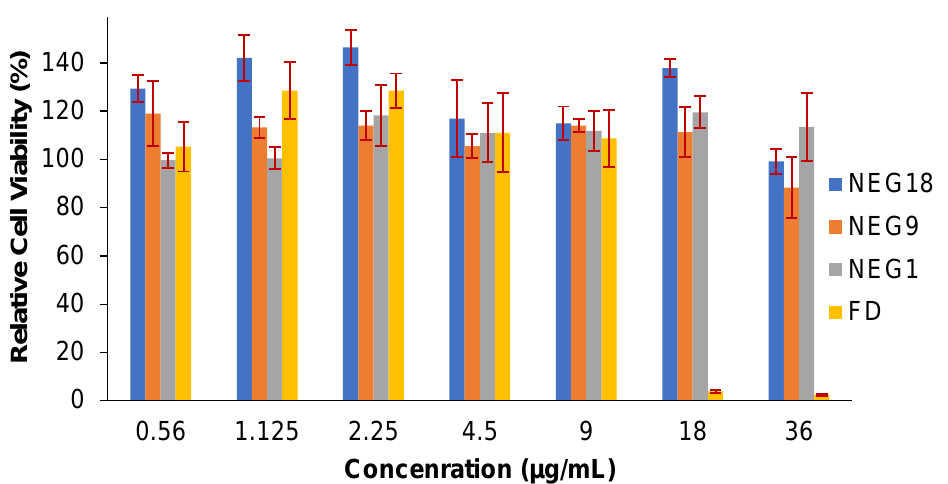
Figure 7. Relative cell viability of three different Tamoxifen-nanogel nanoparticles (NG31,NGE9 and NGE18) and free Tamoxifen Citrate (FD) after their incubations for 24 h with a breast cancer cell line (MCF-7). The data are the result of the MTS assay, which is expressed as relative cell viability (%) and presented as the mean ± SD ( n = 3), p > 0.05.